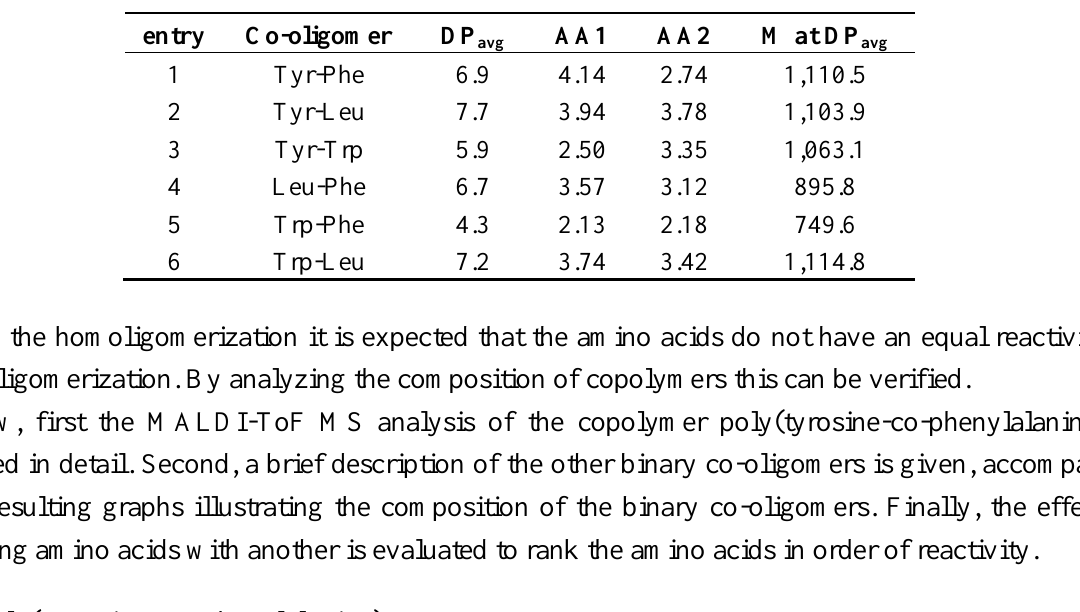
Table 3. Composition of binary co-oligomers composed of amino acids AA1 and AA2 at DP and mass at DP avg avg